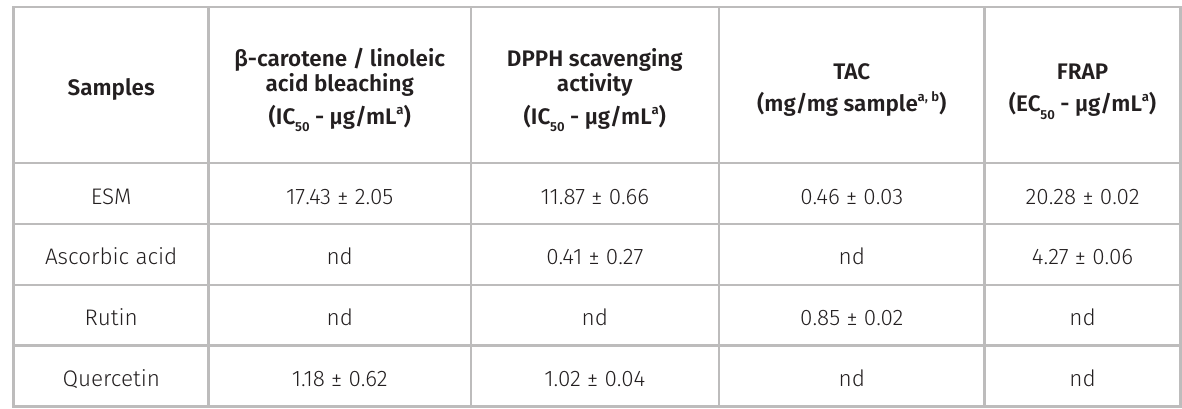
Table I. Antioxidant activity of Syzygium malaccense methanolic extract (ESM) evaluated by β-carotene/linoleic acid, DPPH, phosphomolybdenum, and FRAP assays.